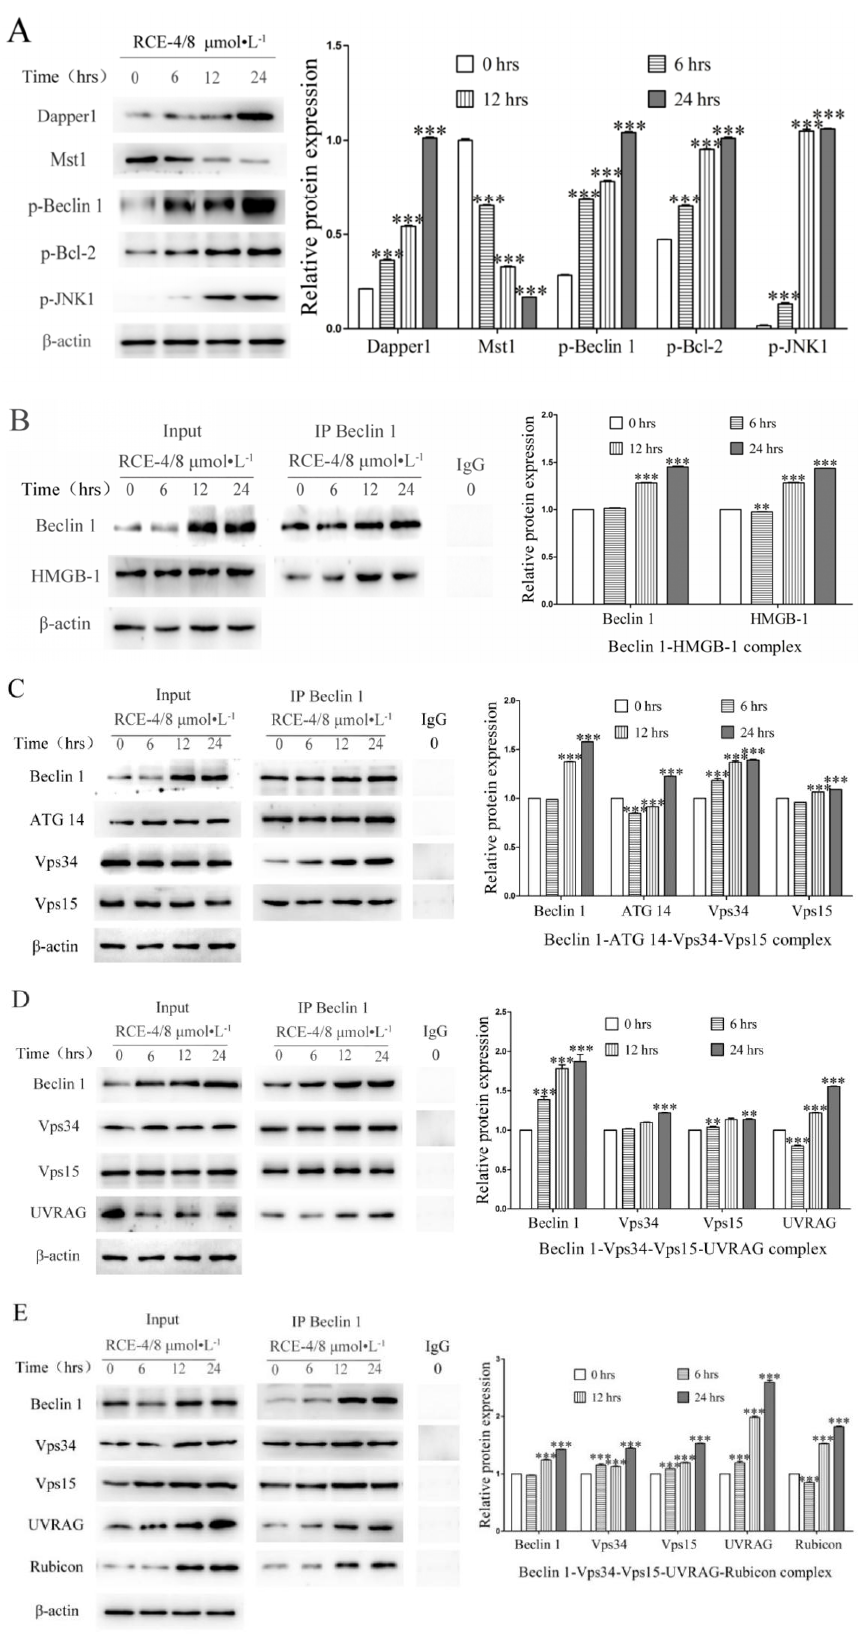
Figure 5. Pathway by which RCE-4 inhibits the formation of the Bcl-2–Beclin 1 complex. ( A ) Protein expression levels in Ca Ski cells treated with RCE-4 at different time points were analyzed by western blotting. β-actin was used as the loading control. ( B ) The content of Beclin 1–HMGB-1 complex was detected by Co-IP assay. Data are presented as the mean ± standard deviation of three independent experiments. *** p < 0.001 vs. Control. ( C ) The content of Beclin 1–ATG 14–Vps34– Vps15 complex was detected by Co-IP assay. Data are presented as the mean ± standard deviation of three independent